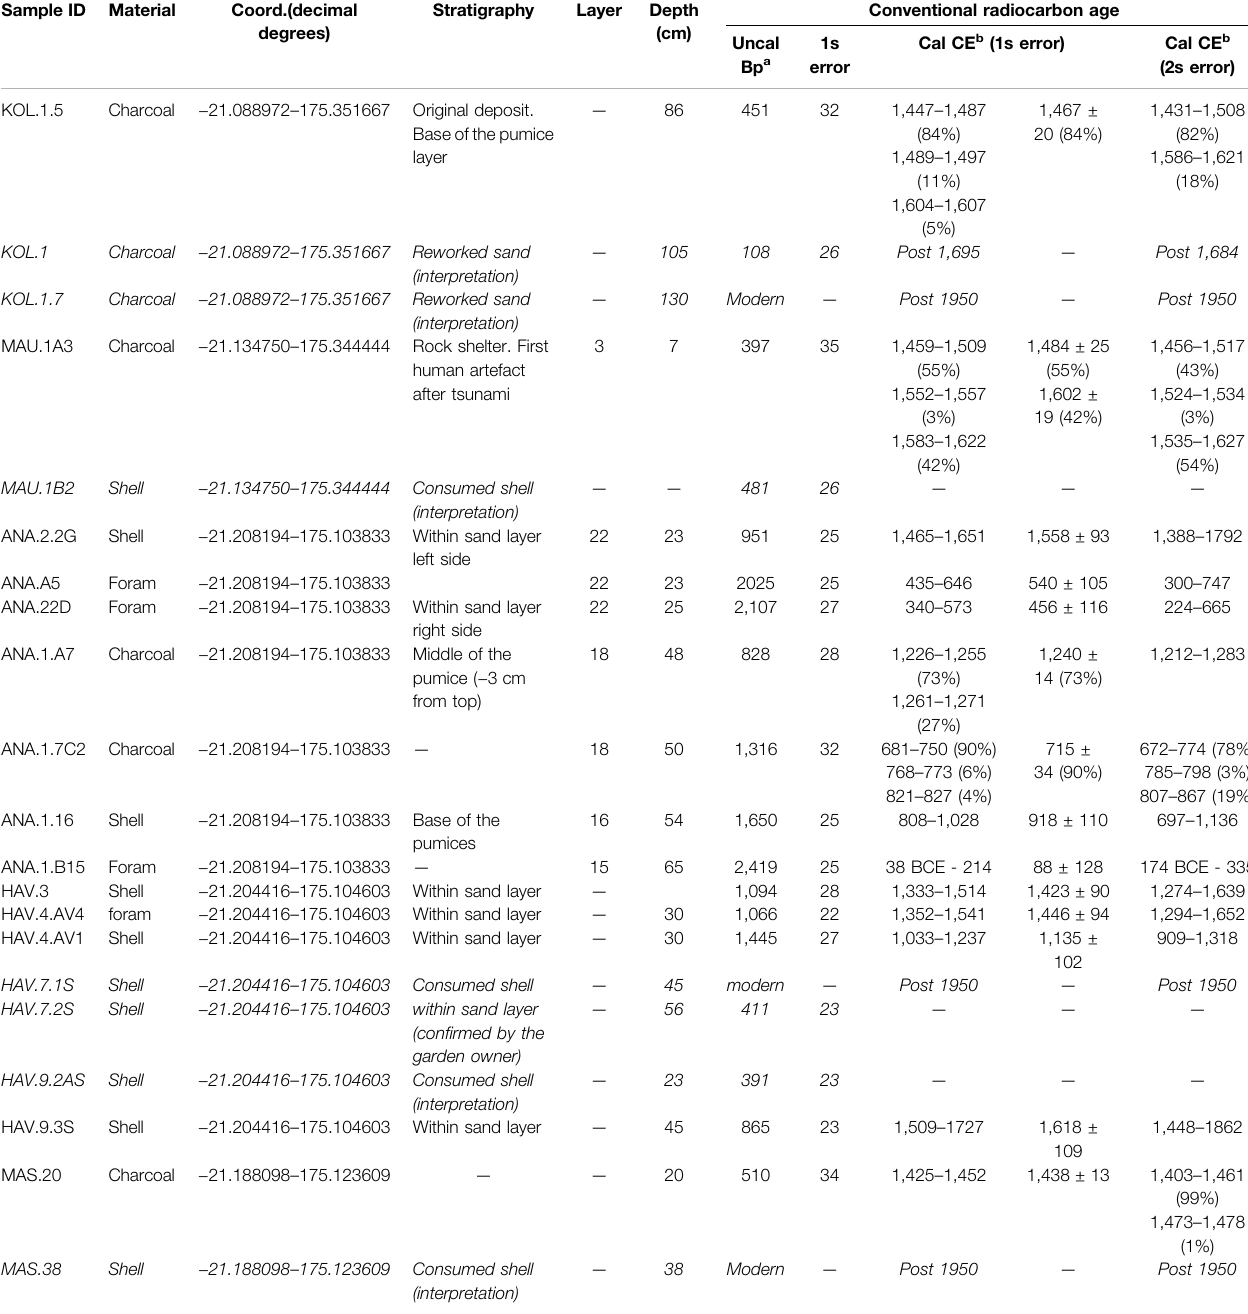
Supplementary Figure S1 , Supplementary Table S1